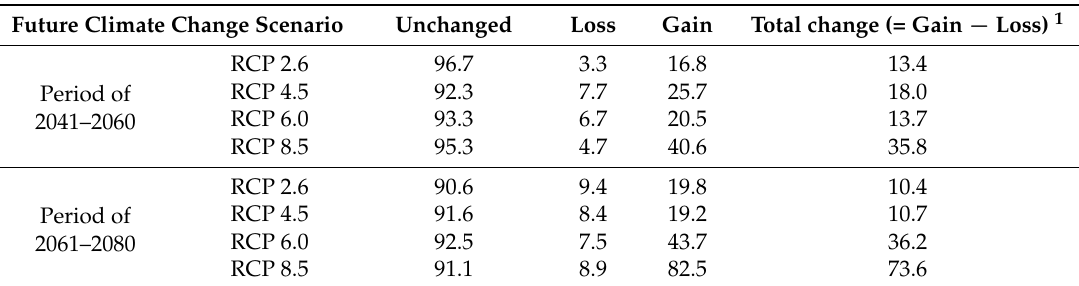
Table 2. Predicted changes in the climatically suitable habitat area (%) of Juglans regia under different climate change scenarios around the world.